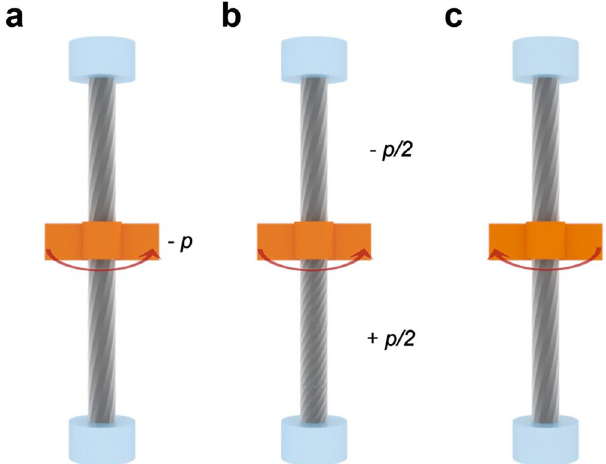
Figure 7. Schematic diagram explaining the torsional behavior of the two-ended tethered CNT yarn. ( a ) The untwisting operation is applied, ( b ) resulting in untwisting in the upper part and further twisting in the lower part. ( c ) Subsequent twisting returns the yarn to the original configuration.